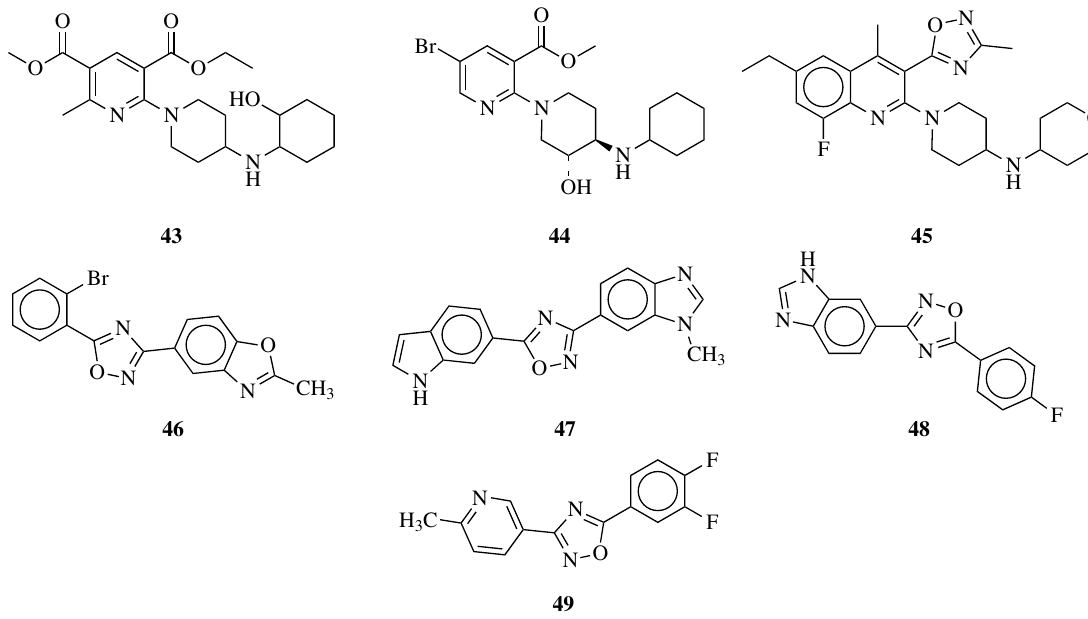
Figure 14. Chemical structures of KOR inhibitors 43 – 45 and Nrf2-ARE activators 46 – 49